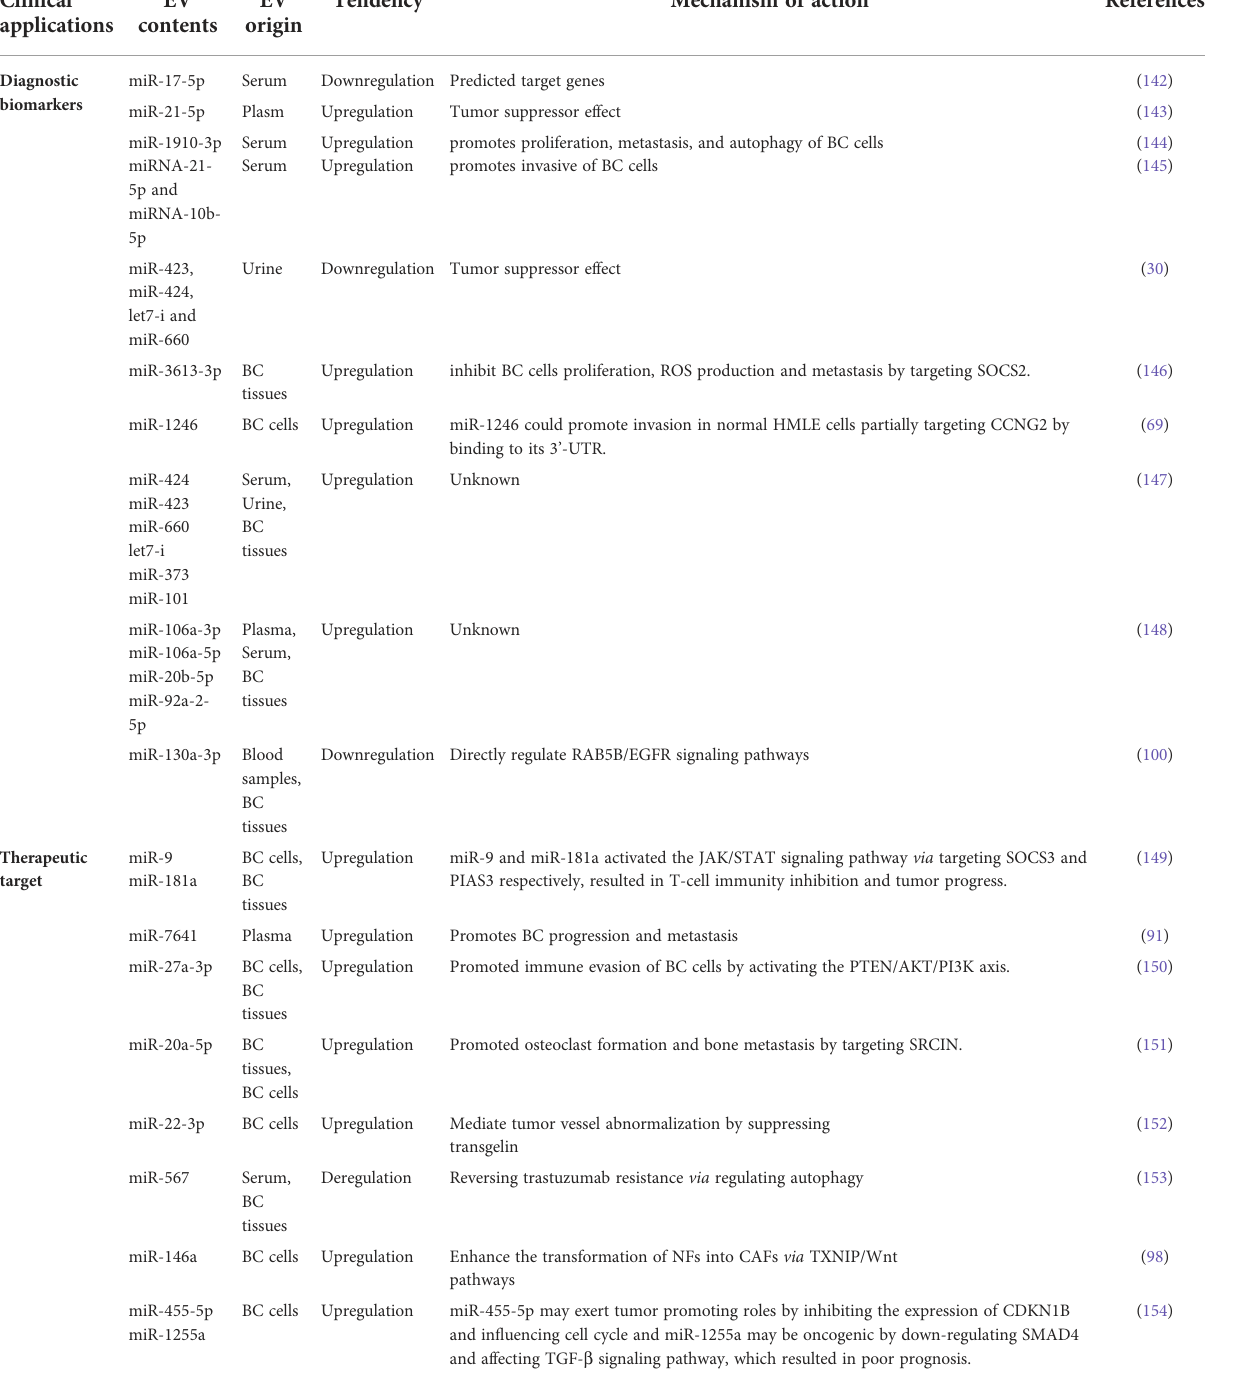
TABLE 1 Clinical applications of breast cancer derived sEVs associated MiRs. Clinical